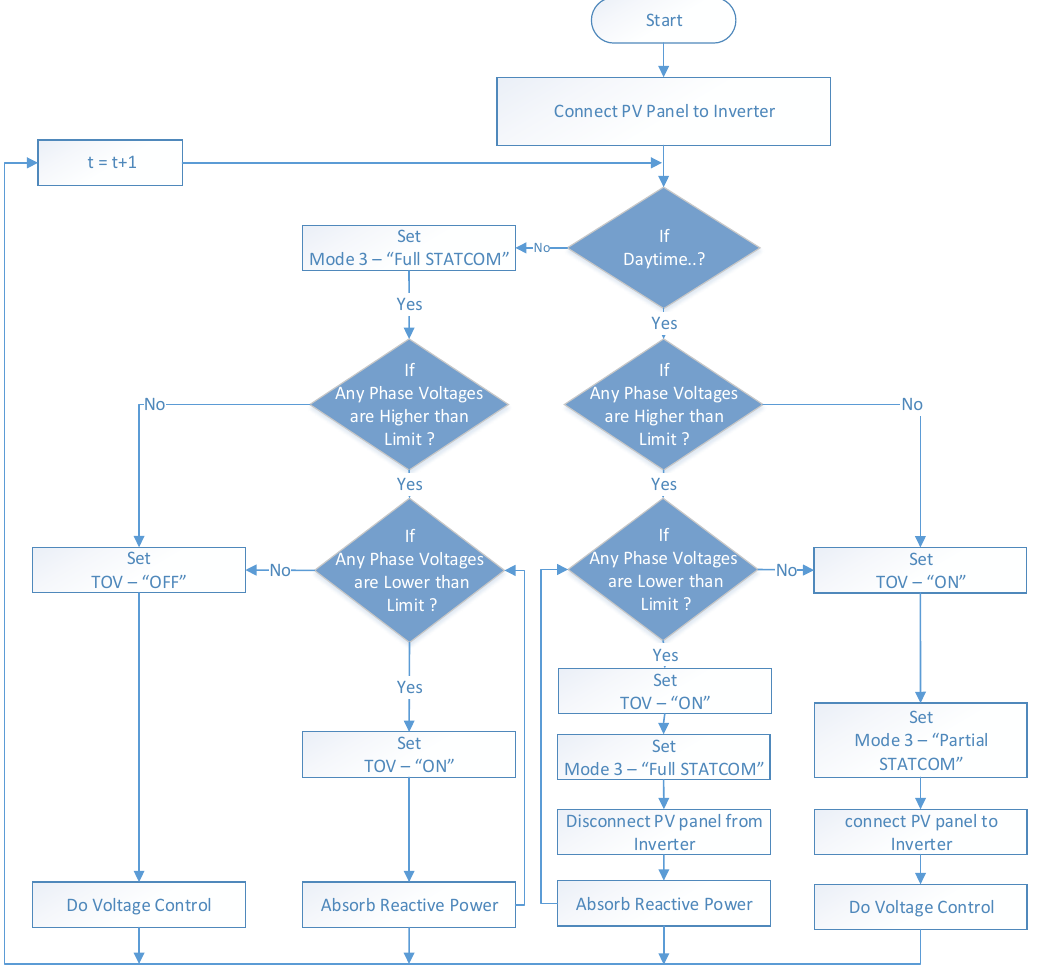
Figure 6. Flowchart for Smart PV inverter operating mode.